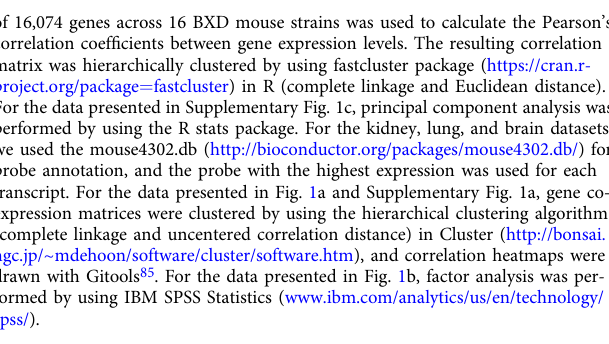
Fig. 7 Tankyrase inhibition stimulates chondrogenic differentiation of mesenchymal stem cells in vitro and in vivo. a Tnks , Tnks2 , and Acan mRNA levels